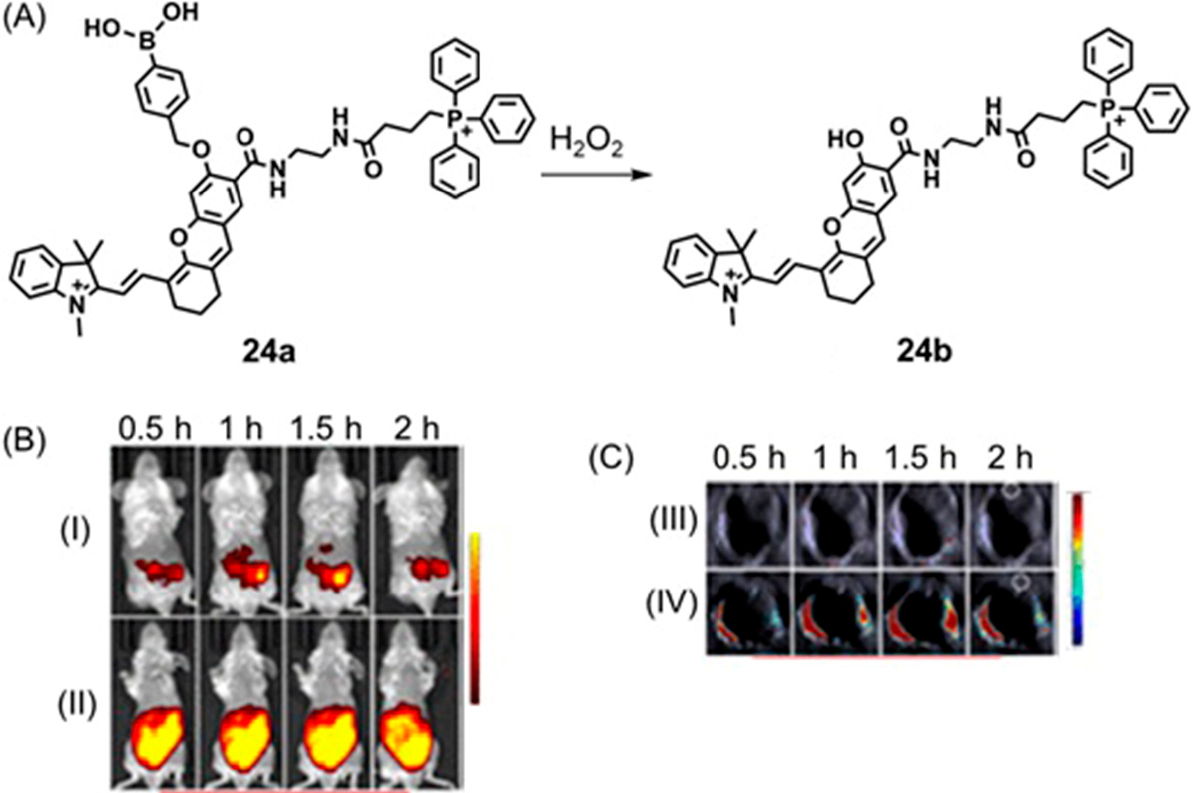
Figure 47. ( A ) Chemical structures of 24a and 24b . ( B ) Time-dependent near-IR fluorescence images and ( C ) time-dependent multispectral photoacoustic images of the abdomen of mice intraperitoneally injected with 24a (250 μ M, 200 μ L). ( B ) (I) and (II) represent the (I) presence and (II) absence of lipopolysaccharide-induced inflammation. ( C ) (I) and (II) represent the (I) presence and (II) absence of lipopolysaccharide-induced inflammation. Adapted with permission from Chen, X.; Ren, X.; Zhang, L.; Liu, Z.; Hai, Z. Mitochondria-targeted fluorescent and photoacoustic imaging of hydrogen peroxide in inflammation. Anal. Chem. , 2020 , 92 , 14244–14250. Copyright 2020 American Chemical Society [360].